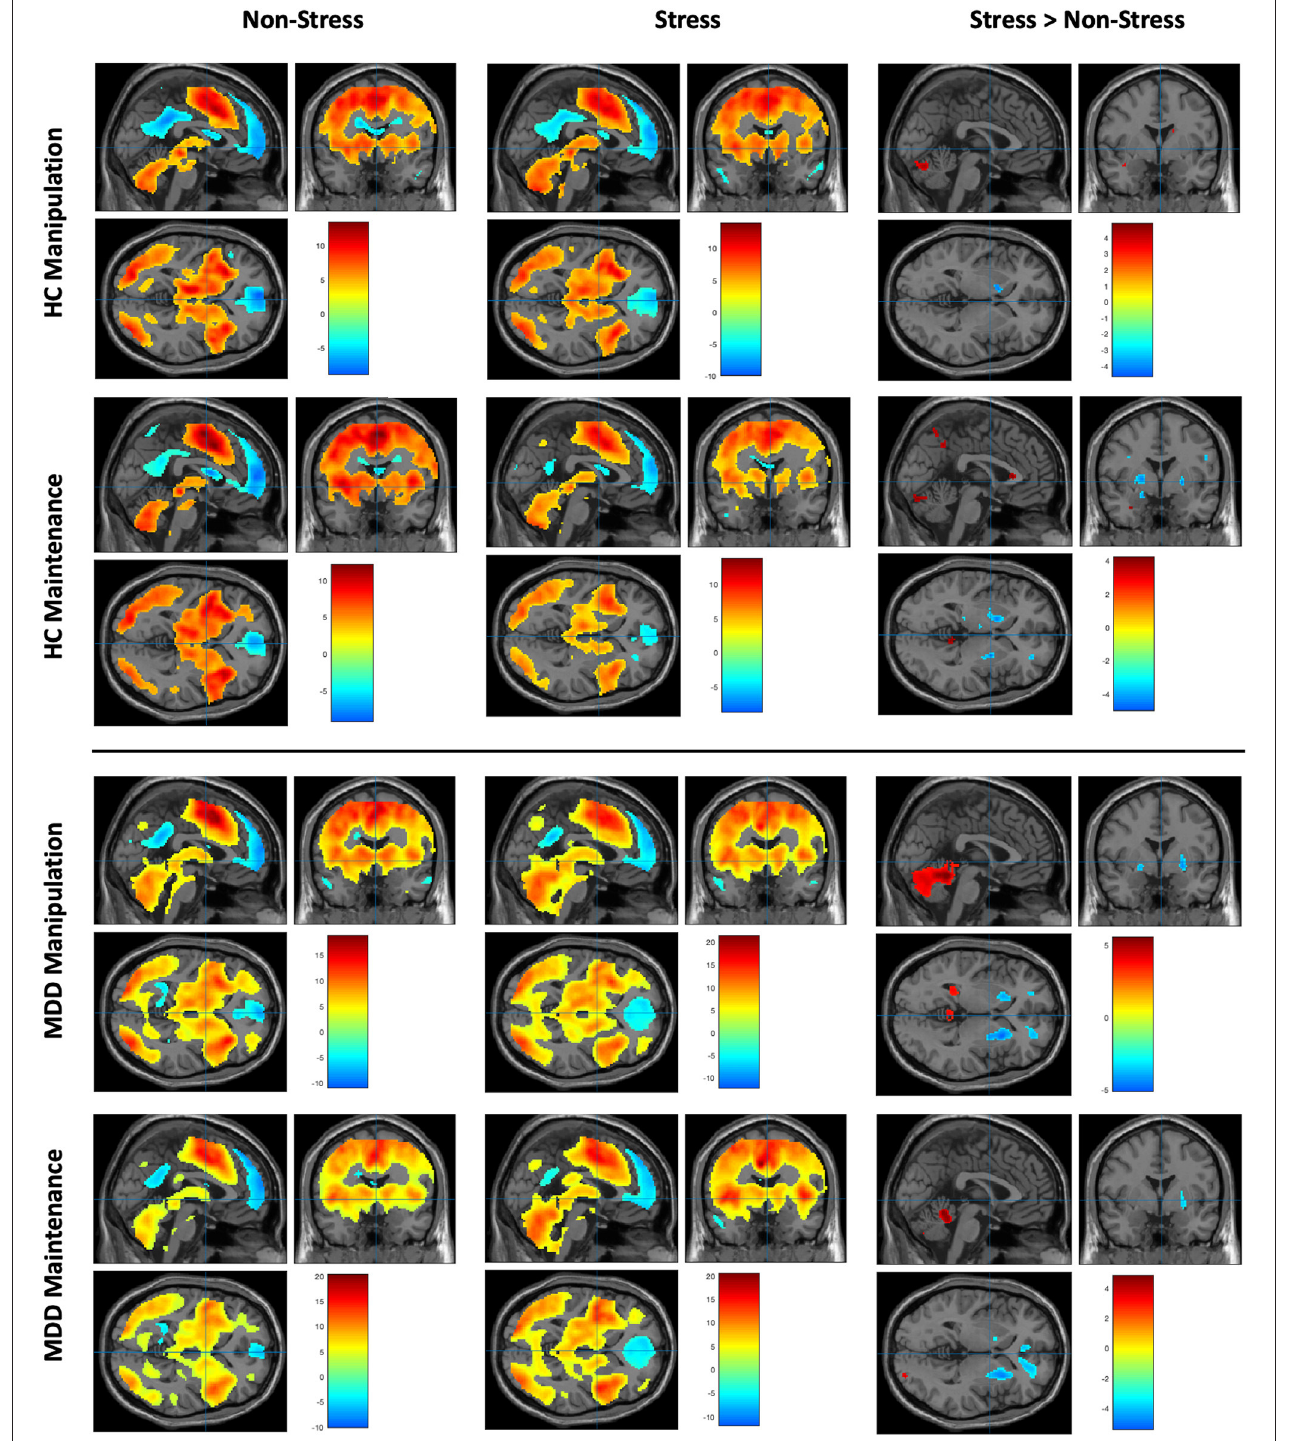
FIGURE 3 | Working memory–related brain activity and stress effect in MDD patients and healthy control subjects (data were shown for p < 0.001, uncorrected). Upper left: The brain activity of WM manipulation and maintenance subtasks in MDD group under non-stress setting. Upper middle: The brain activity of WM manipulation and maintenance subtasks in MDD group under stress setting. Upper right: The brain activity of comparison of stress vs. non-stress setting within the MDD group under different subtask patterns. Bottom left: The brain activity of WM manipulation and maintenance subtasks in HC group under non-stress setting. Bottom middle: The brain activity of WM manipulation and maintenance subtasks in HC group under stress setting. Bottom right: The brain activity of comparison of stress vs. non-stress setting within the HC group under different subtask patterns.